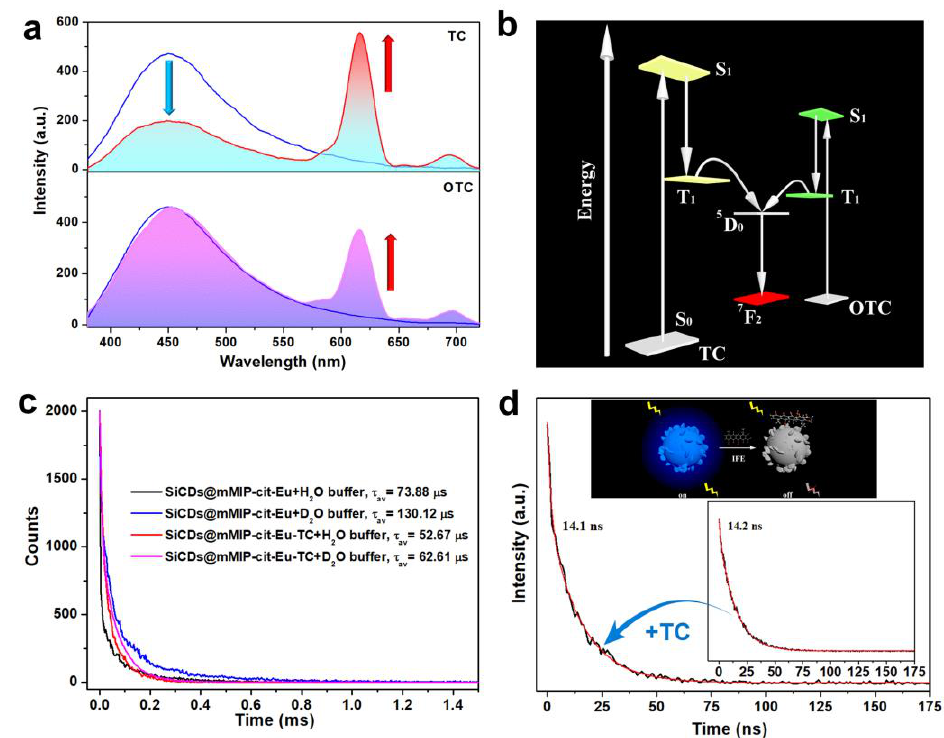
Figure 4. ( a ) Fluorescence emission spectra of SiCDs@mMIP-cit-Eu in the absence and presence of 3.5 μM of TC (top) and OTC (bottom). ( b ) Energy transfer mechanism diagram from TC and OTC to Eu 3+ . ( c ) The lifetime of SiCDs@mMIP-cit-Eu and SiCDs@mMIP-cit-Eu-TC nanomaterials in H 2 O and D 2 O buffers. ( d ) The lifetime SiCDs in the absence (right) and presence (left) of TC (Inset: schematic diagram of IFE process).